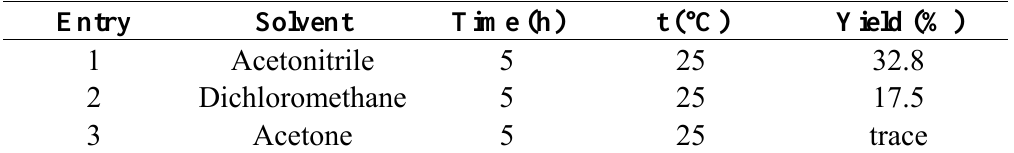
Table 1. The effect of solvent on the yield of compound 7b .